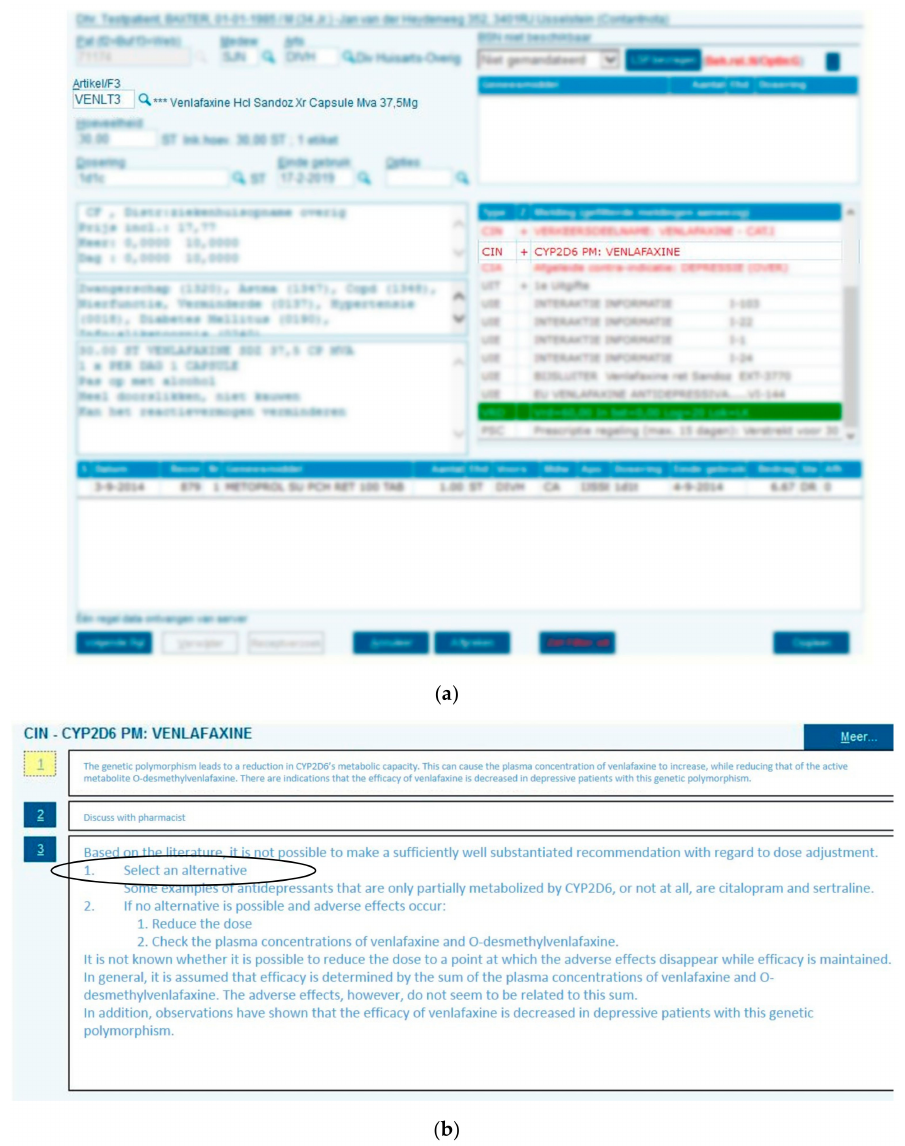
Figure1. Clinicaldecisionsupportduringdrugdispensing. Apatientwhois CYP2D6 PM(asnotedinthe electronic medical record (EMR) as contra-indication, as indicated by “CIN” (contra-indication) receives a prescription for venlafaxine ( a ) which triggers a pop-up with the relevant Dutch Pharmacogenetics Working Group (DPWG) recommendation directing selection of alternative drug ( b